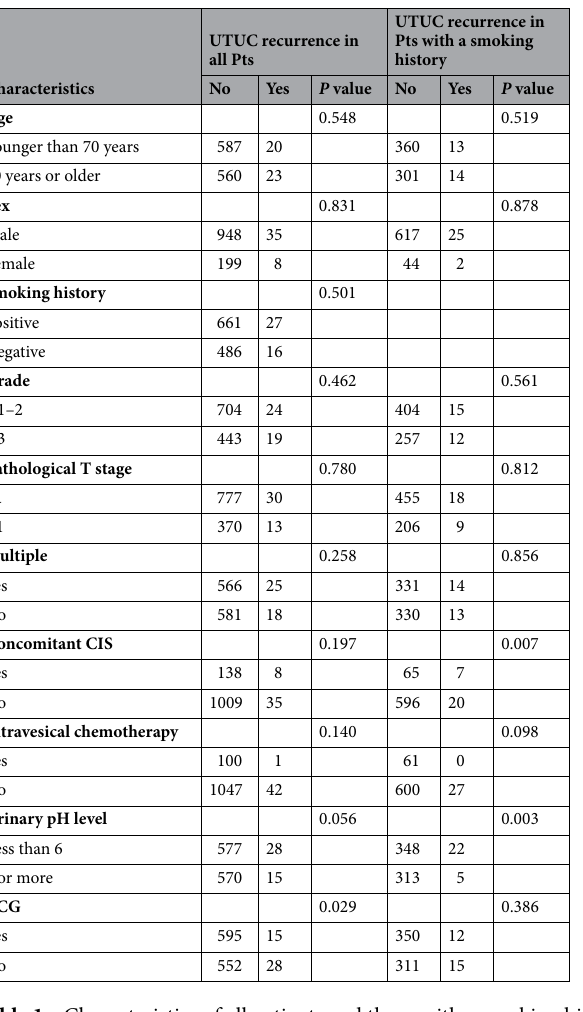
Table 1. Characteristics of all patients and those with a smoking history according to UTUC recurrence after TURBT. UTUC, upper urinary tract urothelial carcinoma; Pts, patients; No, number; CIS, carcinoma in